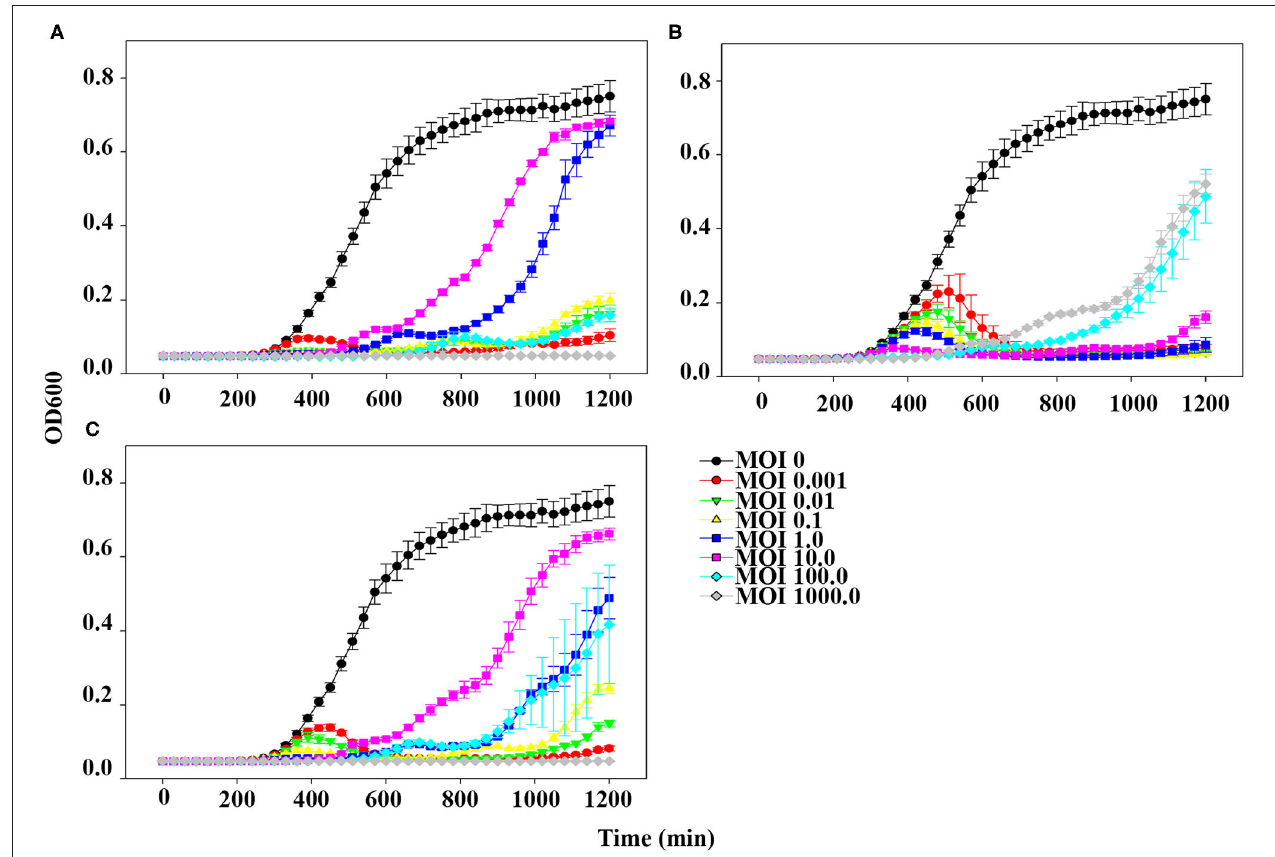
FIGURE 4 | The kinetics for planktonic bacterial cell lysis by (A) pSp-J, (B) pSp-S, and (C) the phage cocktail. Lytic activity was tested on methicillin resistant S. pseudintermedius C21-2-1 strain with phages at different concentrations, namely multiplicity of infection (MOI) of 0 (control), 0.001, 0.01, 0.1, 1, 10, 100, and 1000. Values are presented as the mean ± standard